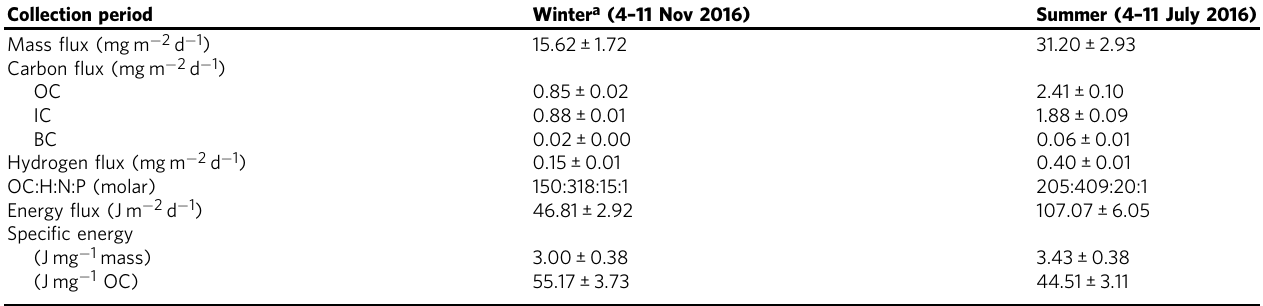
Table 3 Mass, carbon, and energy fl uxes of sinking particulate matter at 4000